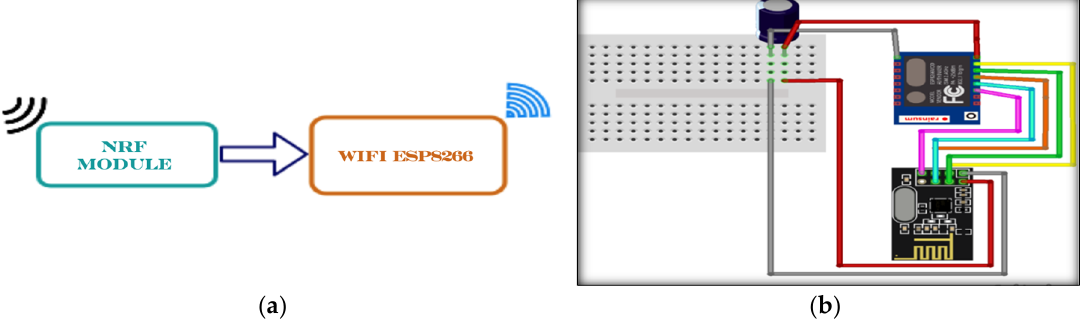
Figure 3. Structure of the gateway node (NG): ( a ) NG block diagram. ( b ) NG connection diagram.